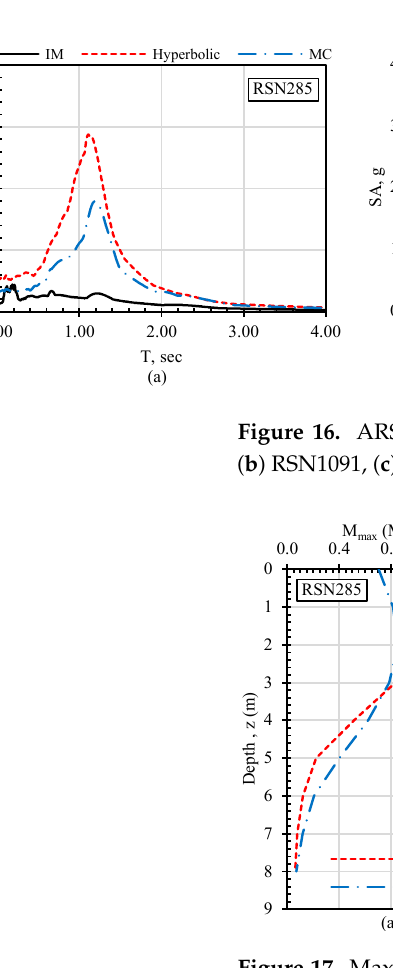
Figure 15. Acceleration time histories of the superstructure using Hyperbolic and MC models ( a )